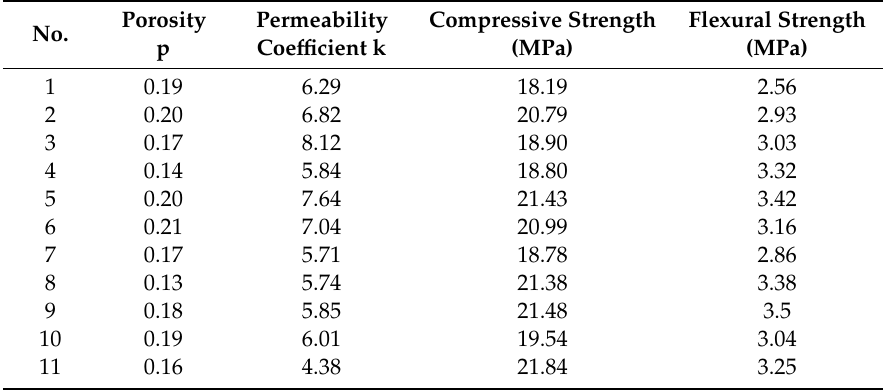
Table 5. Summary of results.